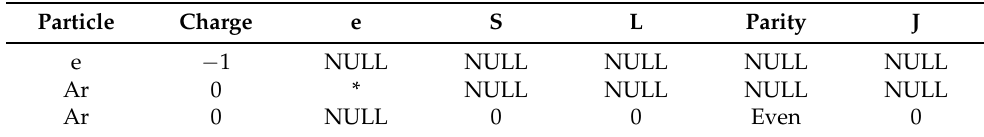
Table 1. Different state entries in the LXCat database can have divergent requirements when it comes to their description, e.g., Ar ∗ vs Ar( 1 S 0 ). Such heterogeneous data can lead to a lot of NULL values.